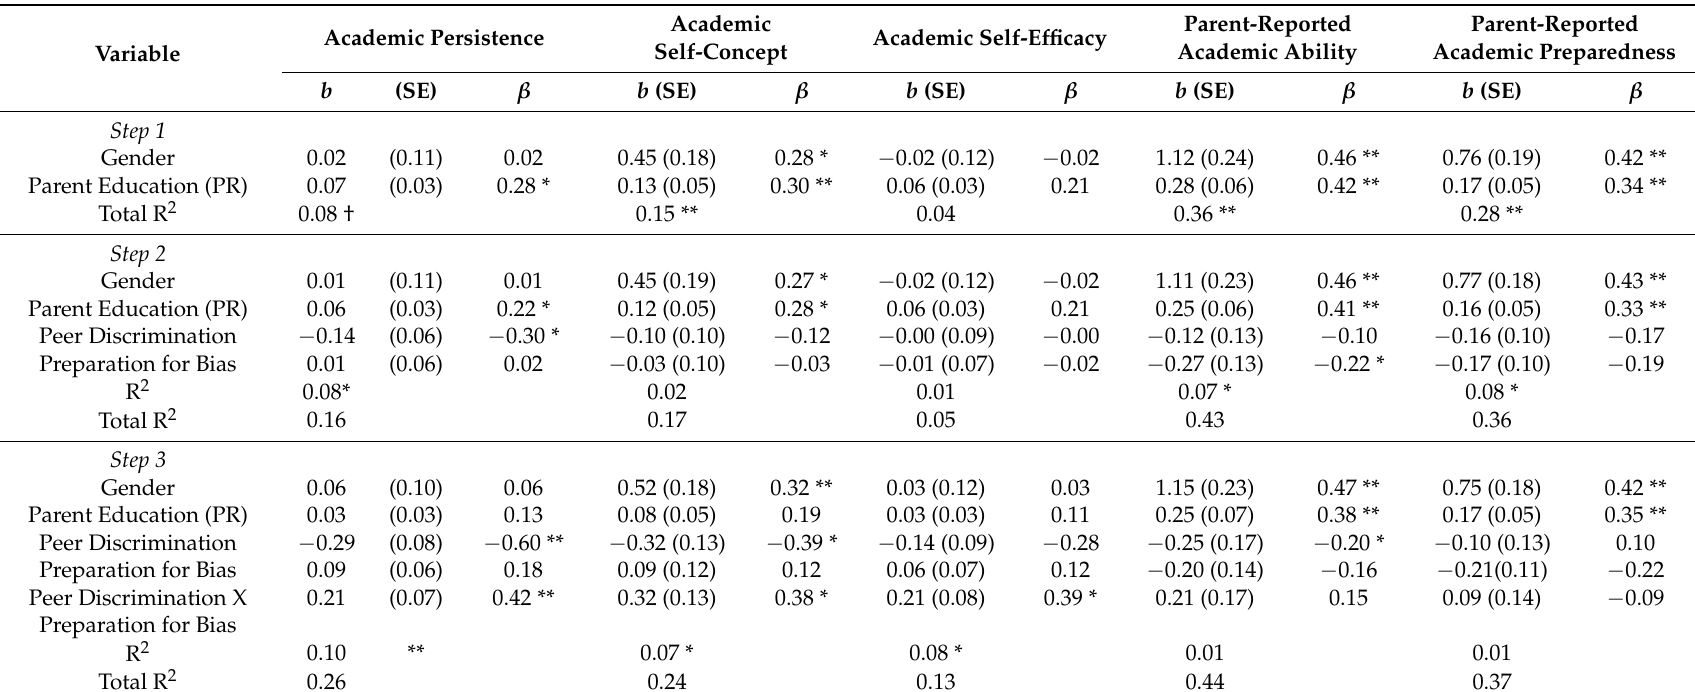
Table 2. Perceived Peer Discrimination by Preparation for Bias: Academic